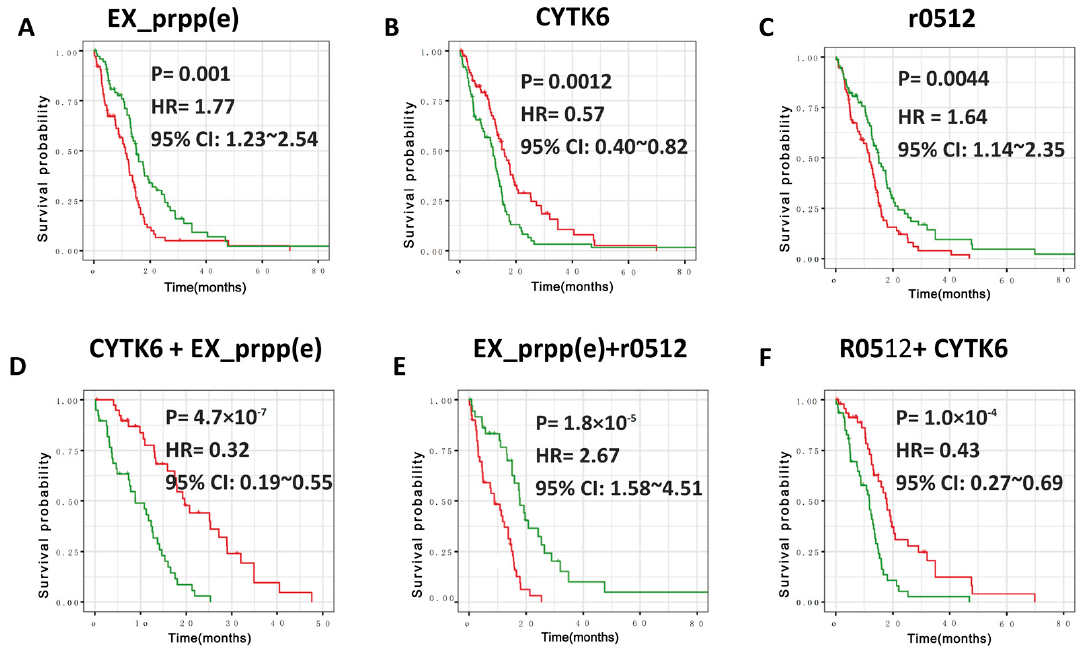
Figure 2. Survival profiles of three different reactions in GBM. ( A – C ): Survival curves of EX_prpp(e), CYTK6 and r0512. Patients with high and low flux are colored red and green, respectively. ( D ): Survival curves of combining CYTK6 with EX_prpp(e) reactions, patients with high and low flux are colored red and green, respectively. ( E ): Survival curves of combining EX_prpp(e) with r0512 reactions, patients with high and low flux are colored red and green, respectively. ( F ): Survival curves of combining R0521 with CYTK6, patients with high and low flux are colored red and green, respectively. To determine whether a combination of markers could further improve the signifi- cance of discrimination in GBM prognosis, we combined two modules out of the three modules. For example, in the combination of nucleotide interconversion (representative reaction: CYTK6) and purine recycling (representative reaction: EX_prpp(e)) (Figure